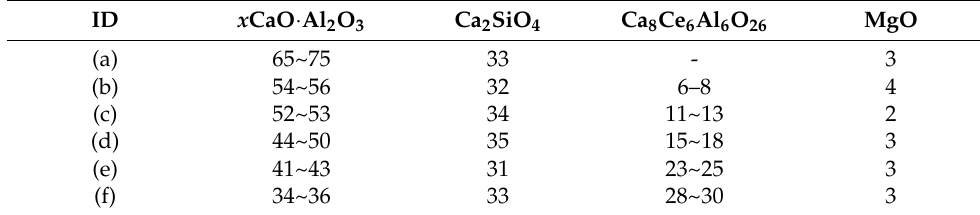
Table 3. Slag’s mineral-phase ratios.